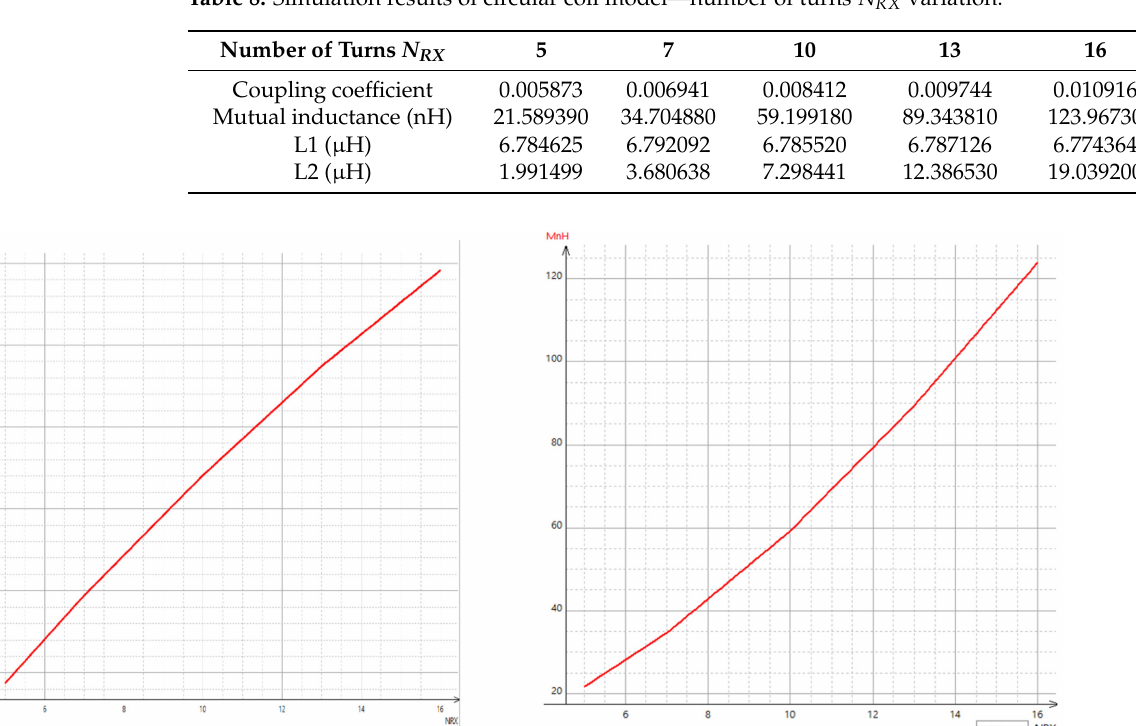
Figure 18. Number of turns simulation results of circular coil model: k in the function of N RX , M in the function of N RX .